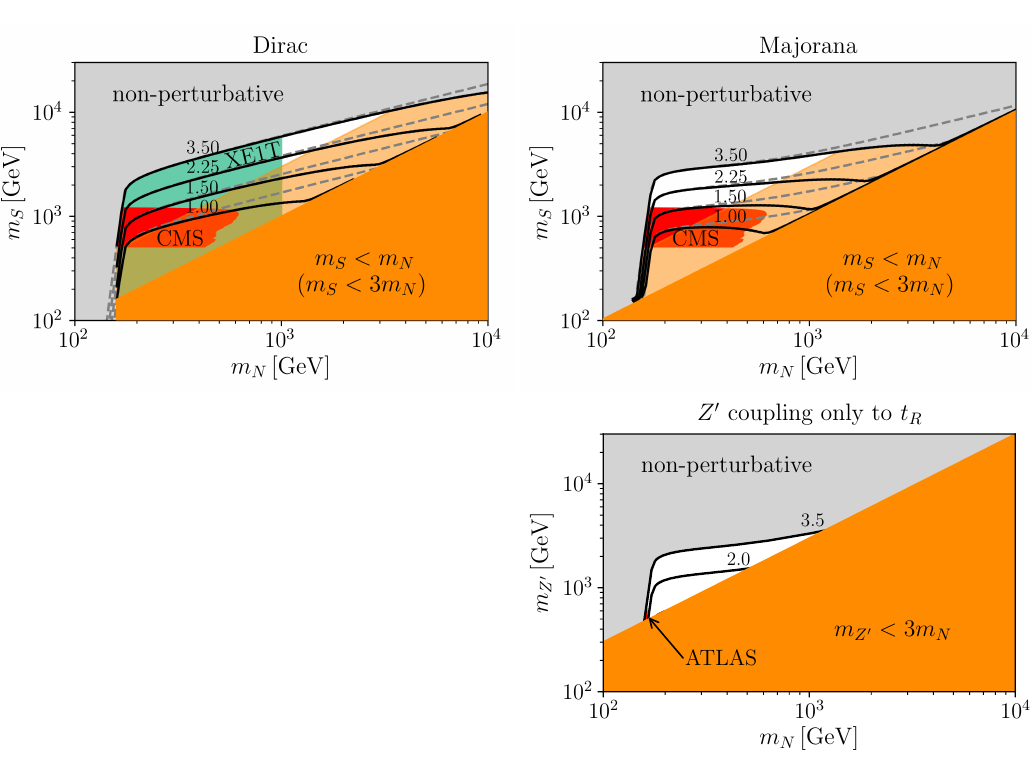
| in the m Figure 6: Upper: contours of | x - m -plane producing the correct relic t N S abundance. Dashed lines correspond to the EFT limit of the given coupling. Con- straints from indirect and direct detection are very weak for Majorana neutrinos. In the case of Dirac neutrinos, direct detection limits from XENON1T are shown in teal. CMS limits are shown in red, perturbativity of the coupling and validity of the < 3 m < m EFT description ( m in orange, m in light orange) are also indicated. S N S N Lower: same plot for Z (cid:48) models coupling only to the B − L charge of right-handed top quarks. Contours of g producing the correct relic abundance are shown in black, X the Z - Z (cid:48) mixing parameter ε is zero. Note the heroic ATLAS blob in the lower